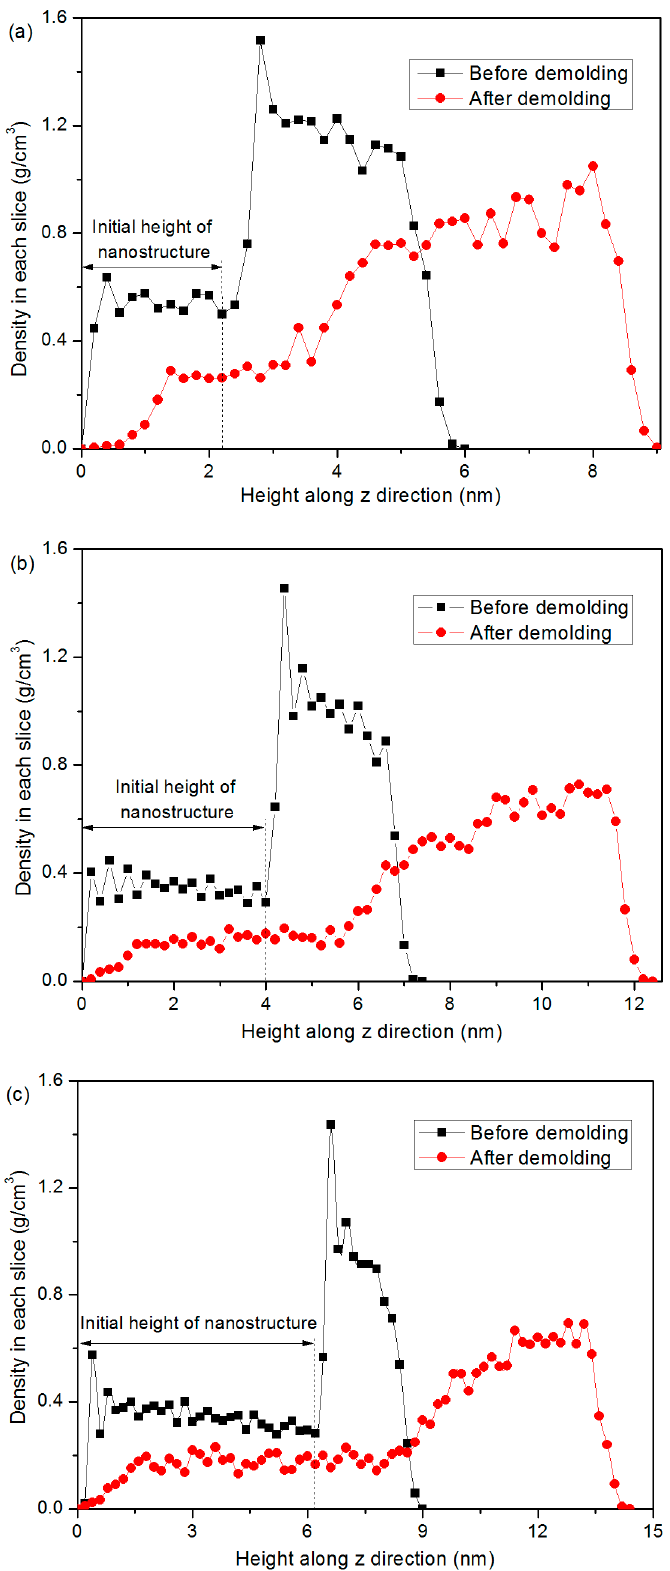
Figure 6. Density profiles in each slice of PP layer before and after the demolding process, with the D / W of these nano-cavities of ( a ) 1:1, ( b ) 2:1, and ( c ) 3:1, respectively.